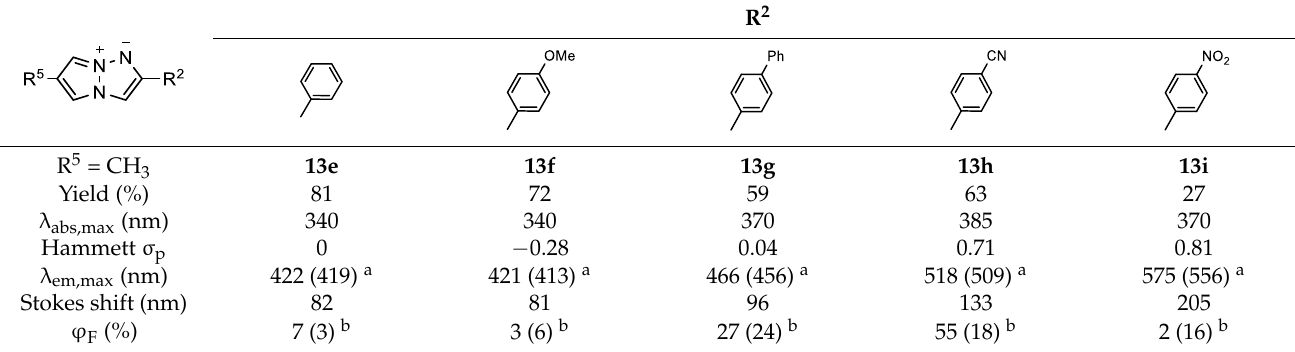
Table 3. Fluorescence properties and reaction yields of 2-substituted 5-methyl-TAPs 13e –i in DCM. R 2